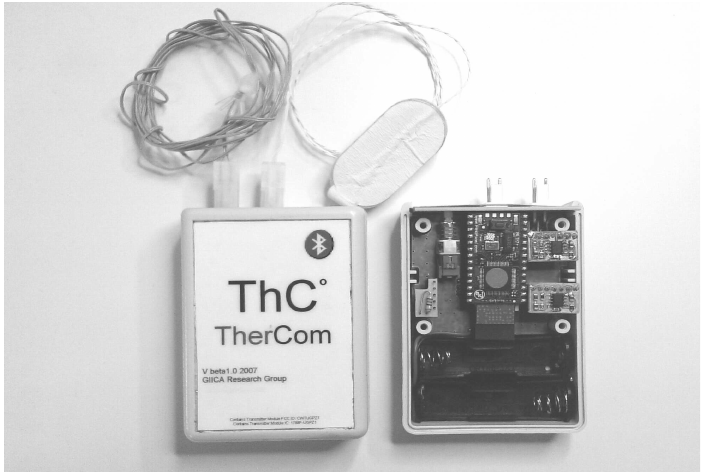
device, for timpanic and peripheral temperature monitoring. The opened device on the right shows the battery holder, Bluetooth module, the two amplifiers, and the microcontroller (the rest of the parts are not